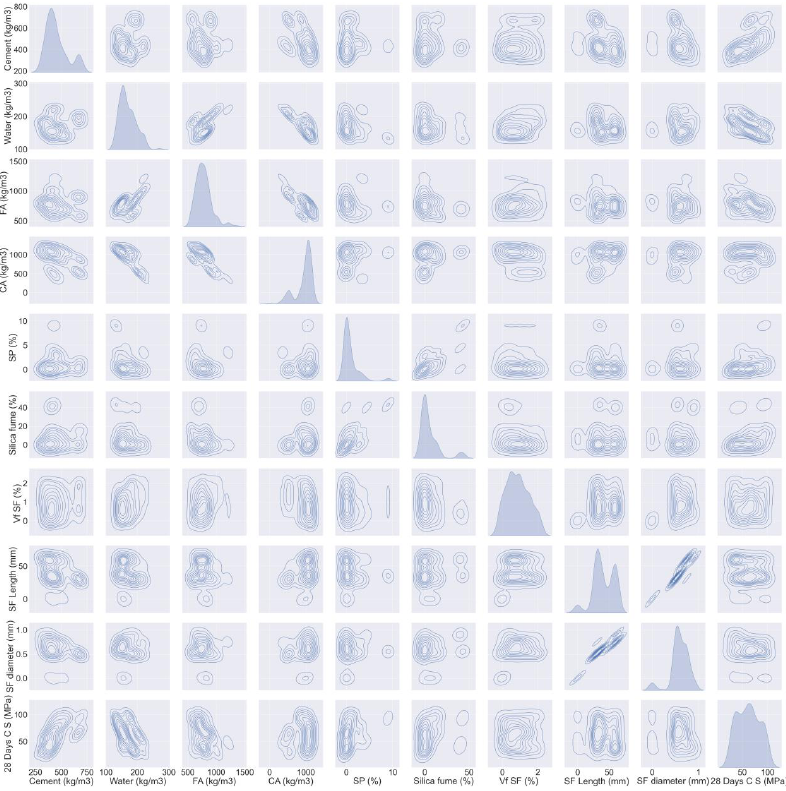
Figure 2. Data description of compressive parameters. Materials 2022 , 15 , x FOR PEER REVIEW